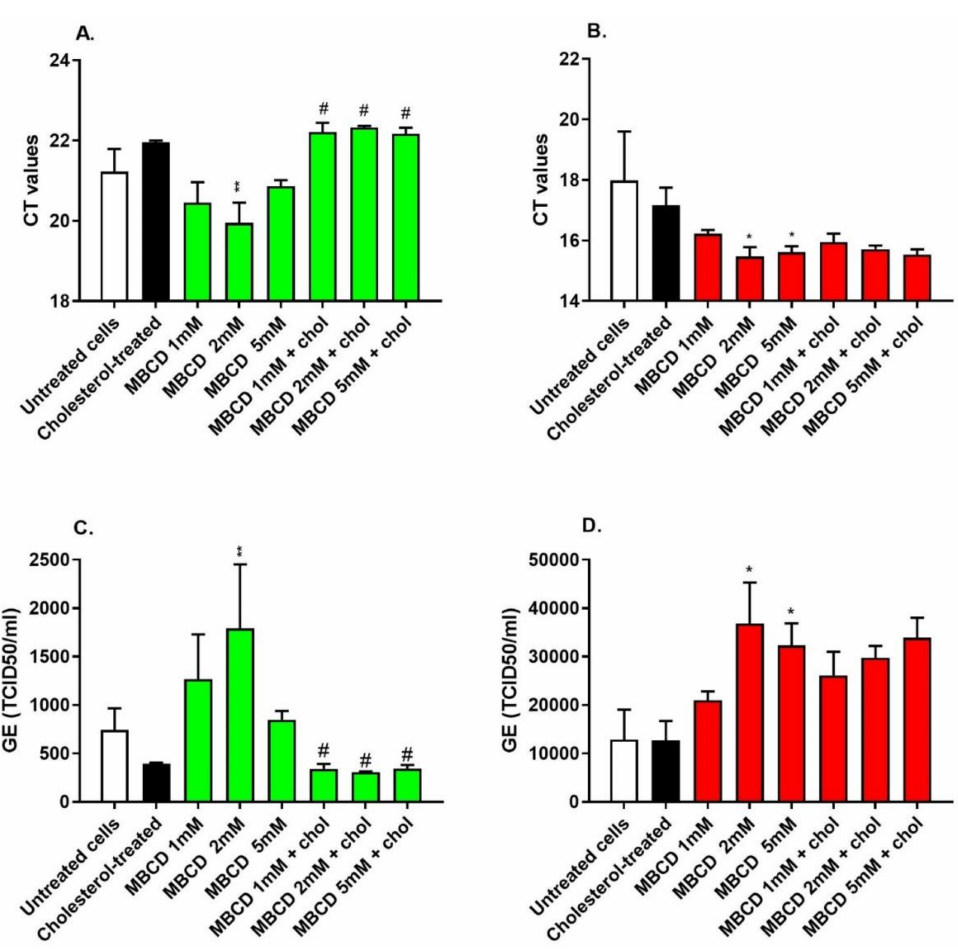
Figure 6. M β CD treatment enhanced wild-type SARS-CoV-2 infectivity in Huh7 and Vero E6 cells. Huh7 and Vero E6 cell lines were treated with different concentrations of M β CD (1 mM, 2 mM, and 5 mM) or cholesterol (0.25 mM) for 1 h. At 48 h p.i., Huh7 cells ( A , C ) and Vero E6 cells ( B , D ) were used for the extraction of total RNA, and cDNA was probed with ORF1a primers using a qRT-PCR assay to determine Ct values ( A , B ) and the cellular viral load ( C , D ). SARS-CoV-2 GE (TCID50/mL) represents the genome equivalent (GE) to the titer of 50% tissue culture infectious dose per ml. Values are plotted as the mean ± SD (N = 3). p values were calculated using a two-tailed Student t -test. * p < 0.05 and ** p < 0.001 vs. untreated control group; # p < 0.05 vs. MBCD-treated